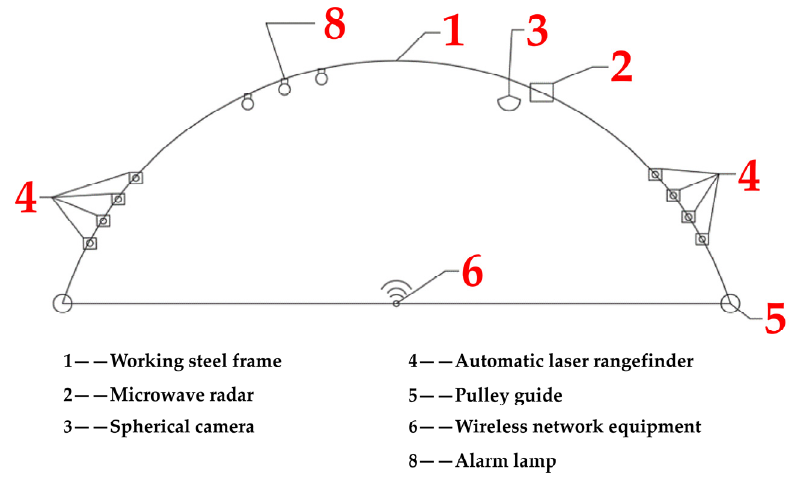
Figure 9. Section layout of the test equipment.